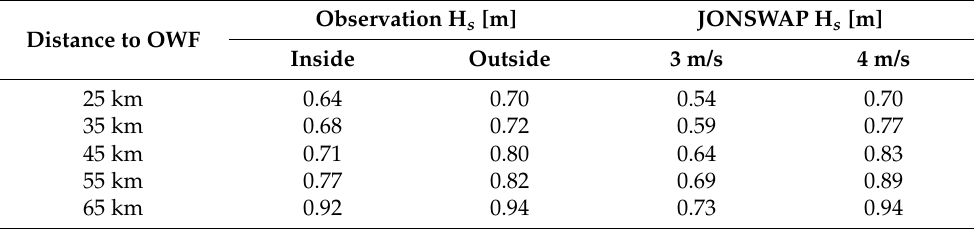
Table 1. Significant wave heights as measured by the scanning laser and predicted by the empirical JONSWAP spectrum. The given values refer to different downstream distances to the offshore windfarm. Observation H s Distance to OWF